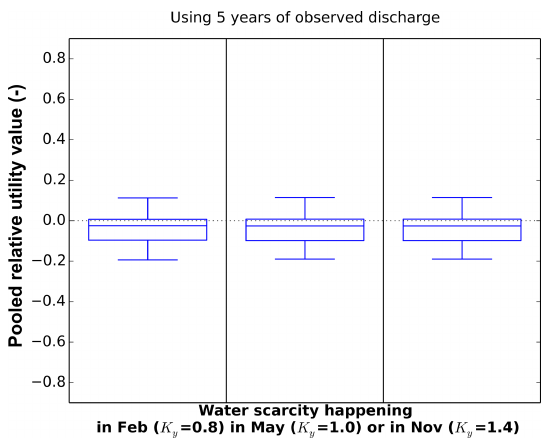
Figure 11. Pooled relative utility value using observed river dis- charge of 5 years for water scarcity happening independently in February, May or November. K y is the sensitivity of the crop to water deficit. Boxplots show the median, interquartile range and minimum–maximum